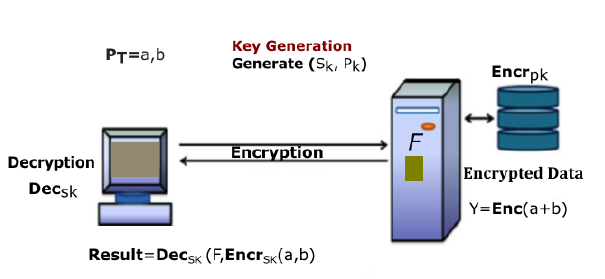
Figure 10. Trapdoor Generation Time using Homomorphic encryption based keyword